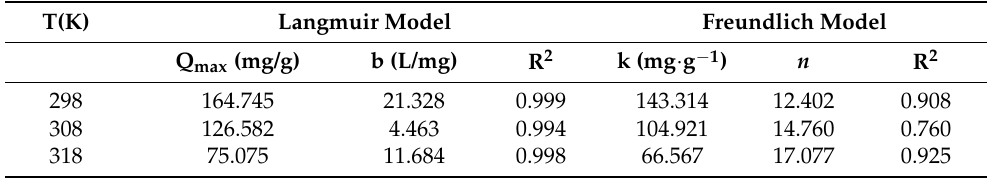
Figure 7. ( a ) Adsorption isotherms for Cr (VI) on S-nZVI@OS at 298, 308 and 318 K; ( b ) Langmuir plot; ( c ) linear plots of lnK d versus C e ; ( d ) linearized Arrhenius plot of ln K as a function of 1/ T . Table 2. Isotherm parameters of S-nZVI@OS removal of Cr (VI).